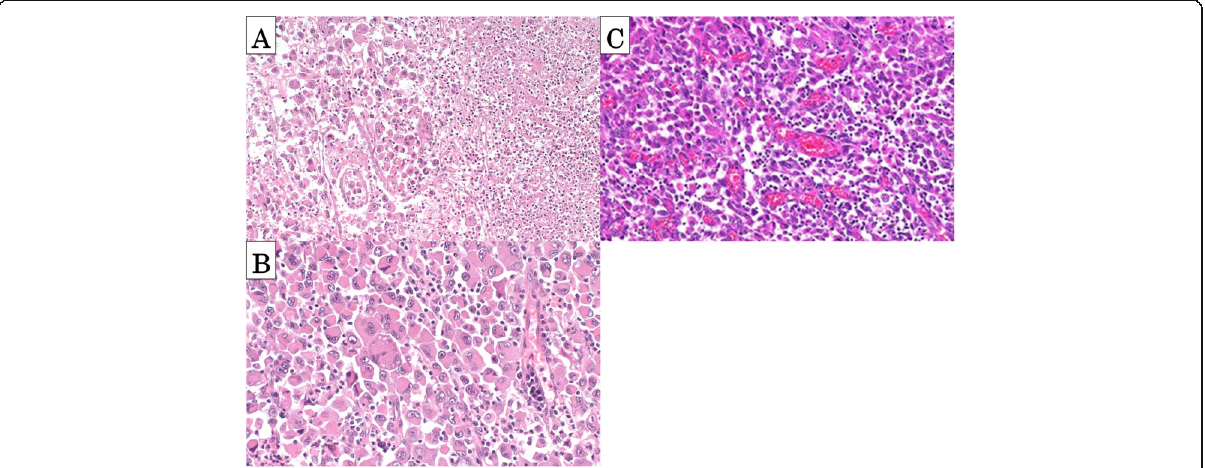
Fig. 3 The pathologic analysis. a , b Pathologic analysis of the lung tumor revealed atypical giant cells with eosinophilic cytoplasms as well as sarcomatous component with necrosis. c Pathologic analysis of the adrenal tumor revealed similar histologic appearance to lung tumor